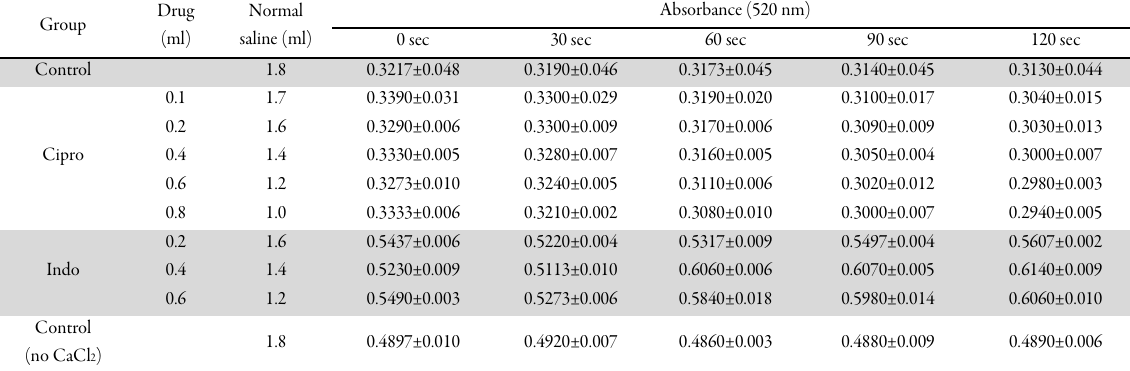
Table 5. Effect of Ciprofloxacin on platelet